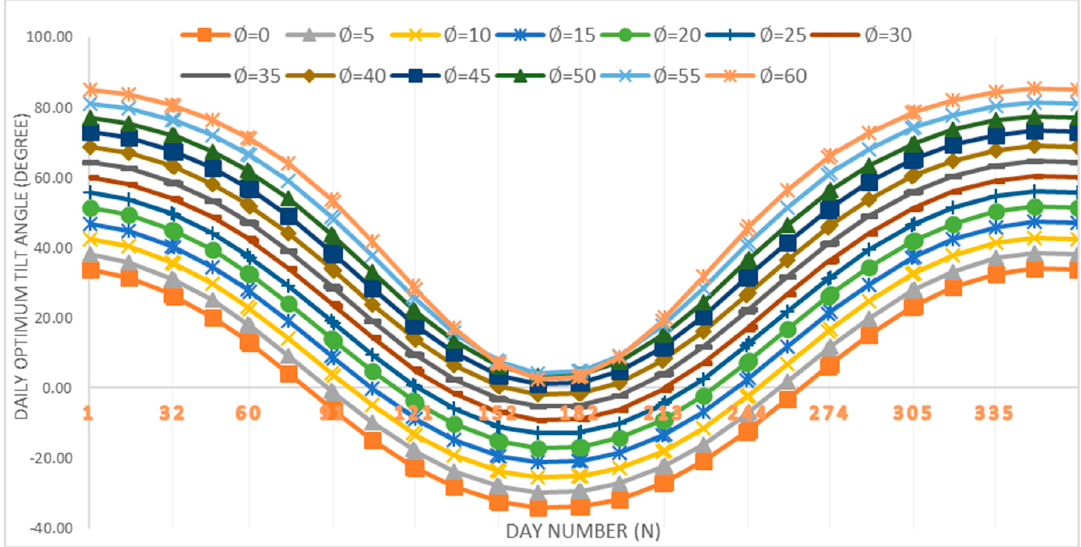
Figure 3. The daily optimum tilt angle β opt,d for different latitude angles.